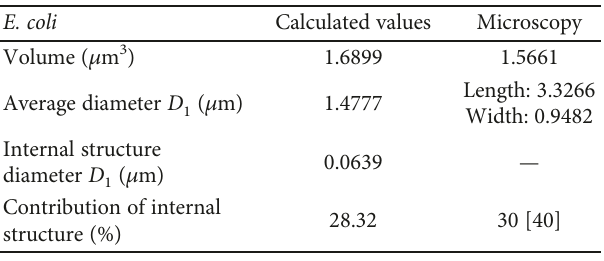
Table 1: The calculated values by scattered spectra of E. coli (400 – 820 nm).